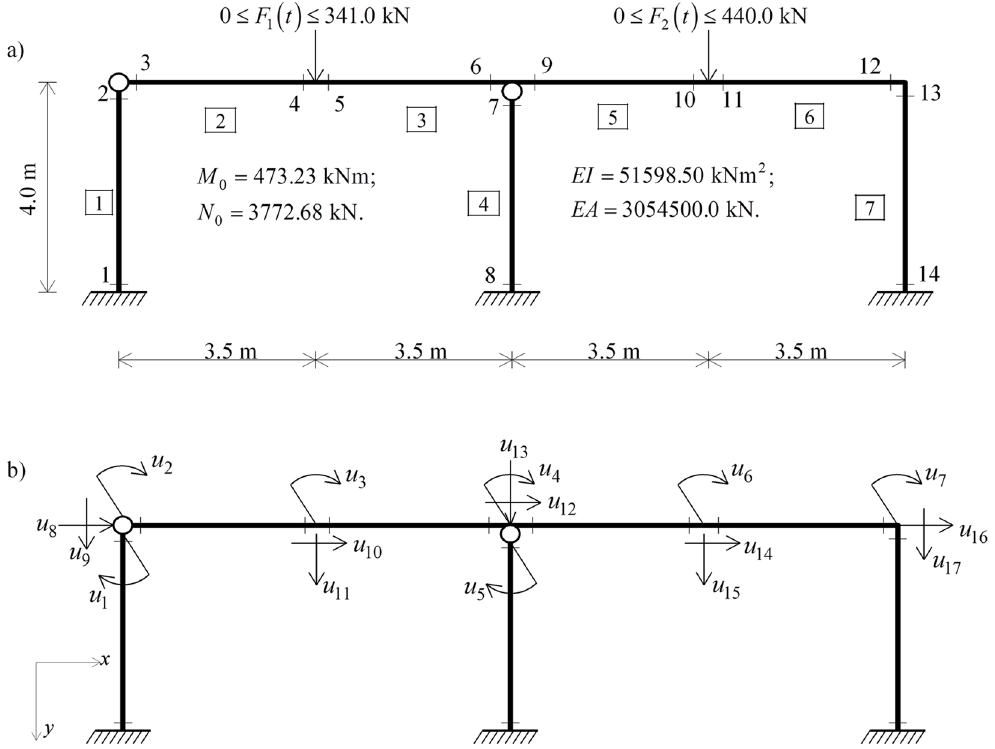
Fig. 1. A discrete model of the two-span frame subjected to the variable repeated loads (element numbers are marked in square ): a) calculation scheme, b) scheme of possible nodal displacements directions (DOF is m =